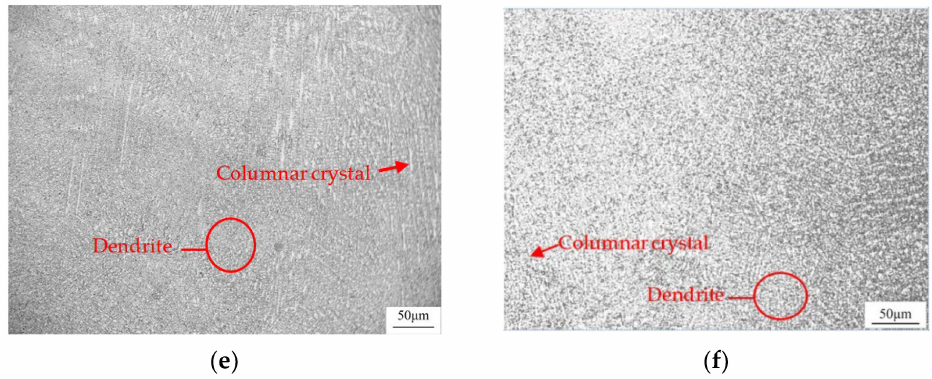
Figure 11. The OM microstructure of the cross-section of the cladding layer in the middle: ( a ) 1#; ( b ) 2#; ( c ) 3#; ( d ) 4#; ( e ) 5#; and ( f ) 6#. Figure 12 shows the SEM microstructures of different cladding layers in the middle. The microstructure of the cladding layer without Nb was presented as a large dendritic solid solution. With the increase in the content of Nb, the dendritic solid solution became gradually refined. When 2% Nb and 5% Nb contents were added, substantial white matter was formed in the inter dendrite. When 10% Nb, 15% Nb, and 20% Nb contents were added, white granular matter was also formed in the dendrites and interdendrites. Moreover, when 15% Nb was added, the microstructure changes were most obvious. In comparison with the cladding layer without Nb, the dendritic solid solution exhibited refinement, and there was a uniform distribution of white granular matter and a eutectic structure in the cladding layer with 15% Nb added.